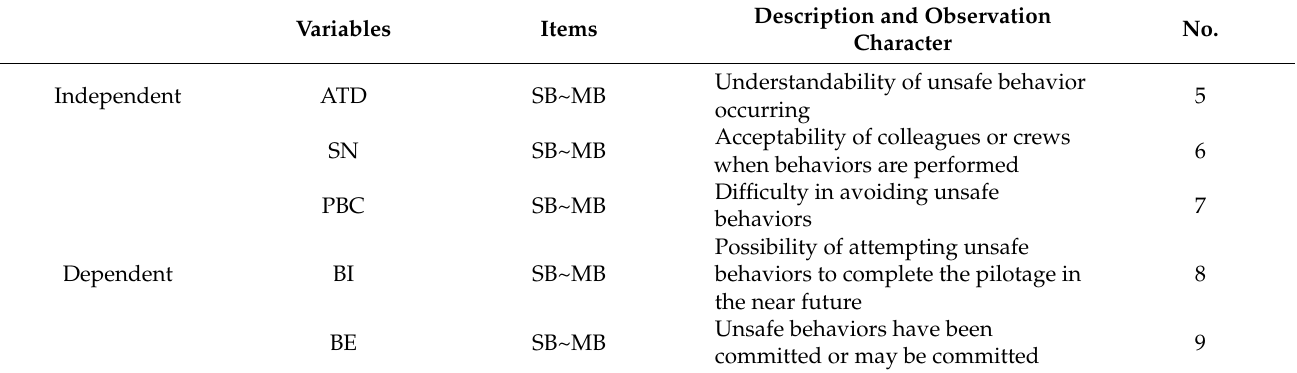
Table 2. Structure of pilot unsafe behaviors survey